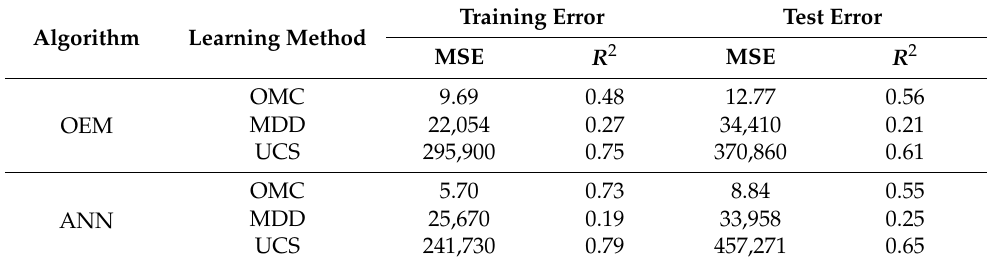
Table 3. Statistical performance evaluation of the developed OEM and ANN-based